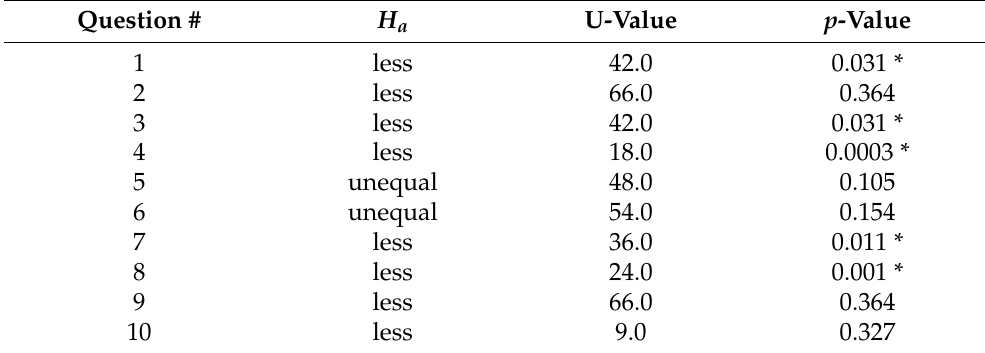
Table 4. Results of the Mann–Whitney U test on questions from question set 2. Question numbers are the same as used in Section 4.4.2. H a refers to whether the alternative hypothesis was that model 1 was evaluated as worse than model 2 (less) or a two-sided test (unequal). * indicates p ≤ α